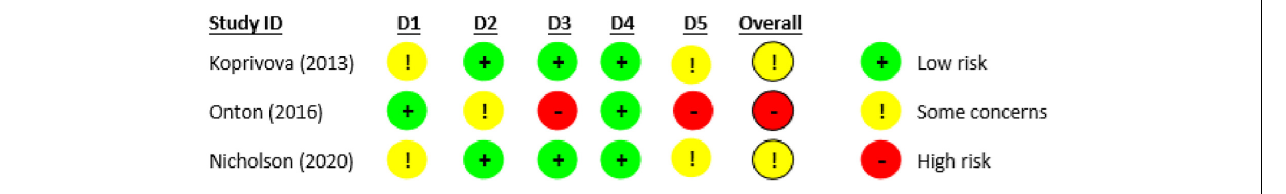
and (Kopˇrivová et al., 2013)] did assess for differential